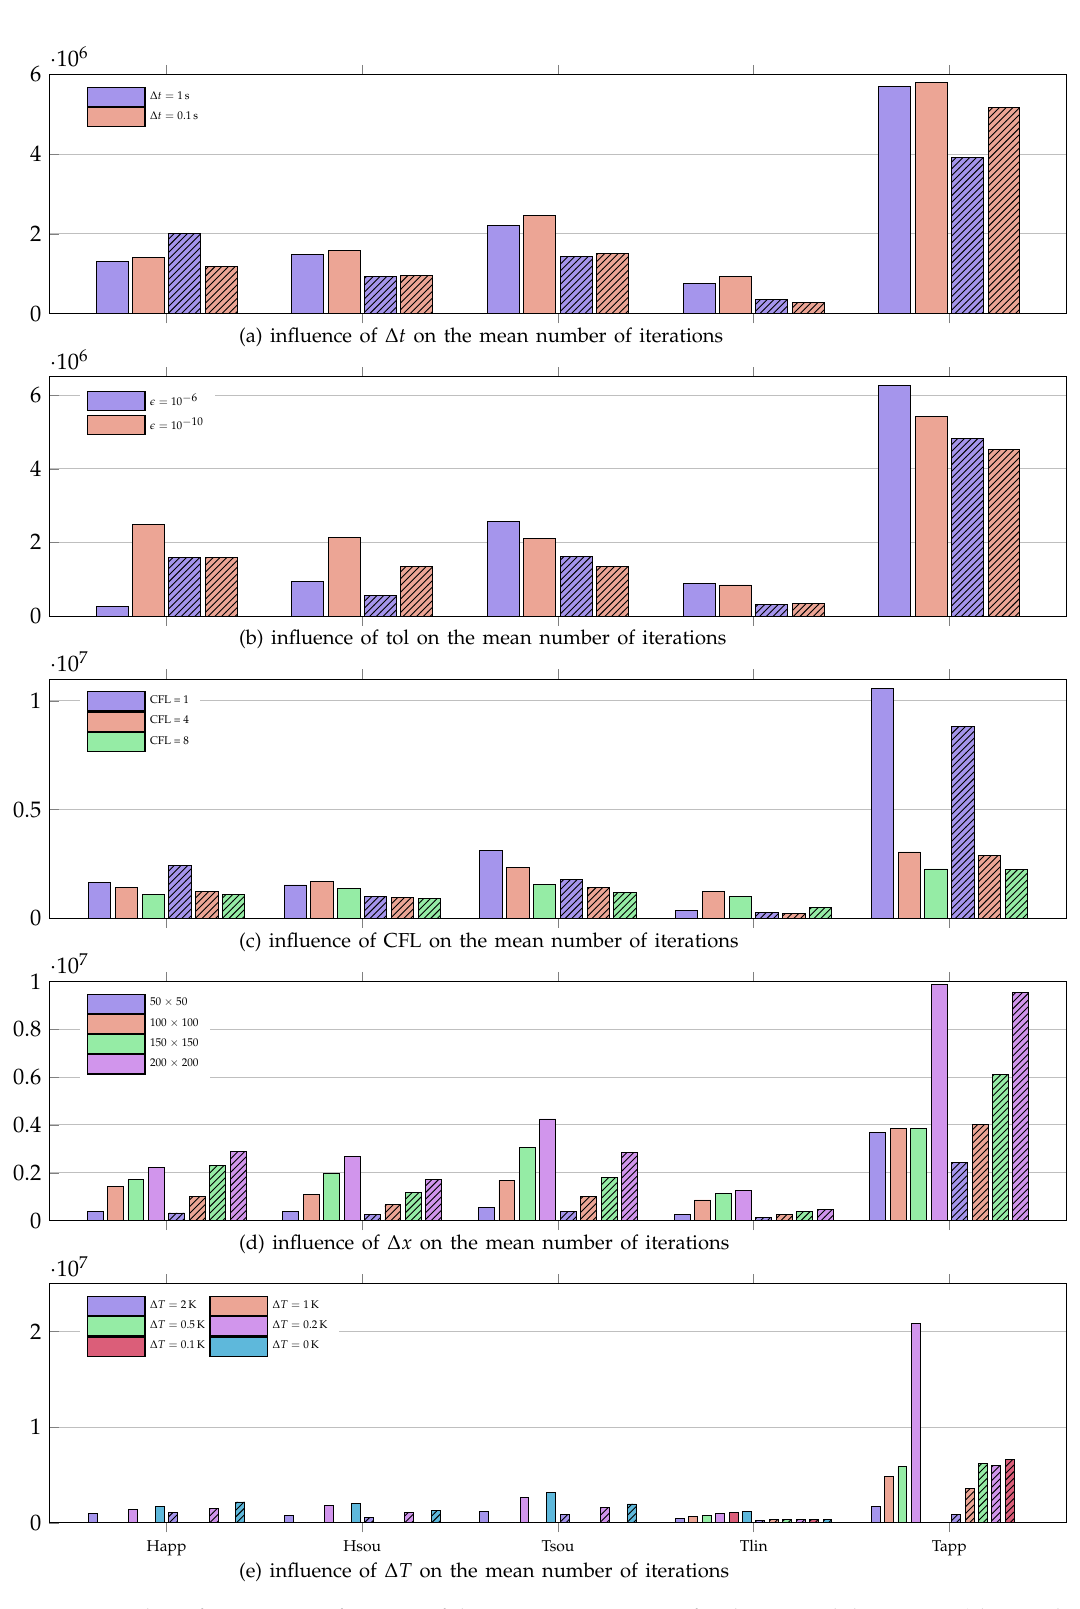
Figure 5. Mean number of iterations in function of the various parameters for the AE and the SE case (clear and striped, respectively).